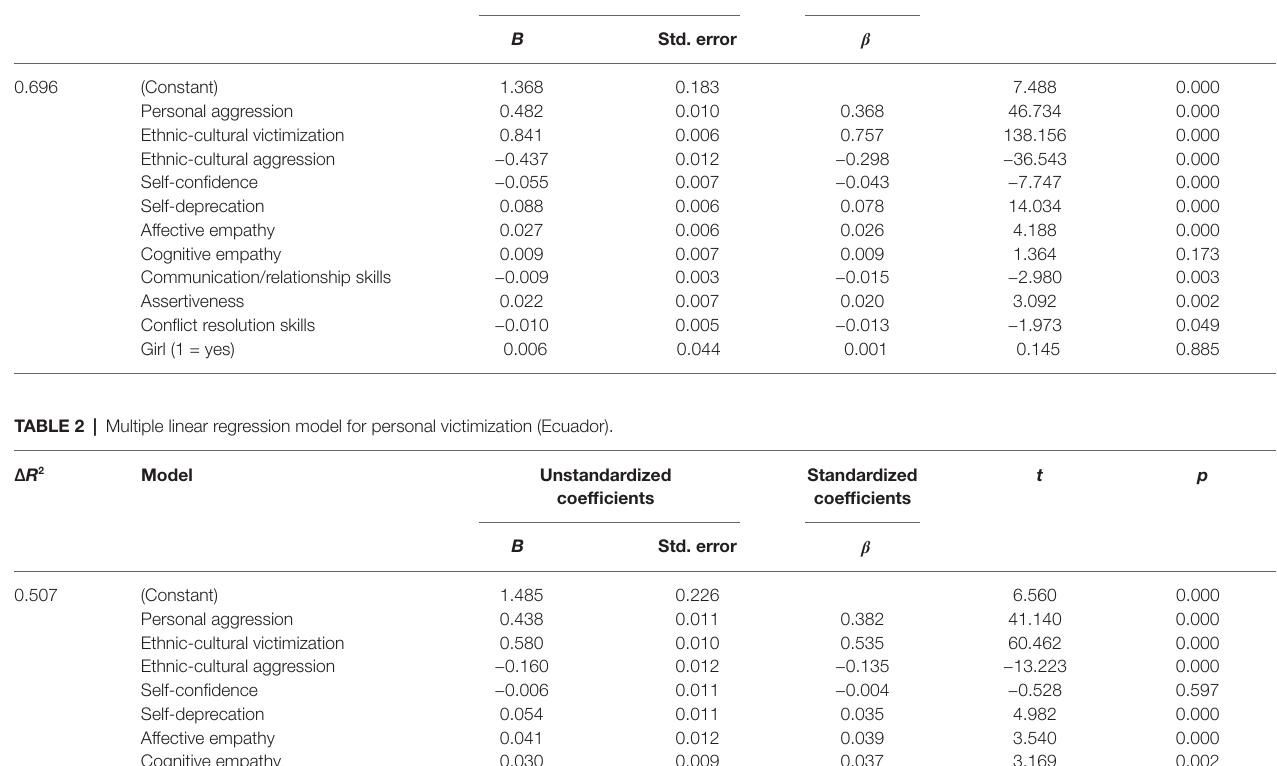
TABLE 1 | Multiple linear regression model for personal victimization (Spain). ∆ R 2 Model